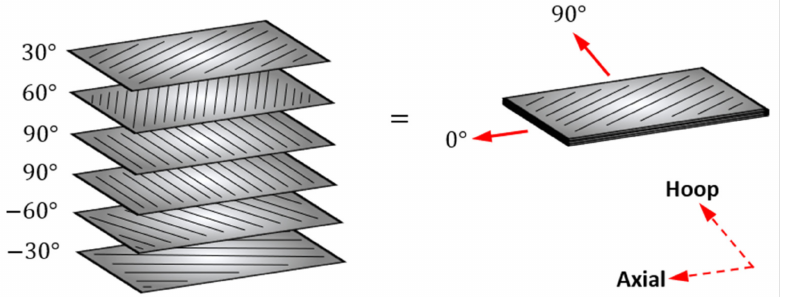
Figure 5. Production of the composite coupons using unidirectional CFRP prepreg, using six oriented plies to attain the desired thickness of 1.85